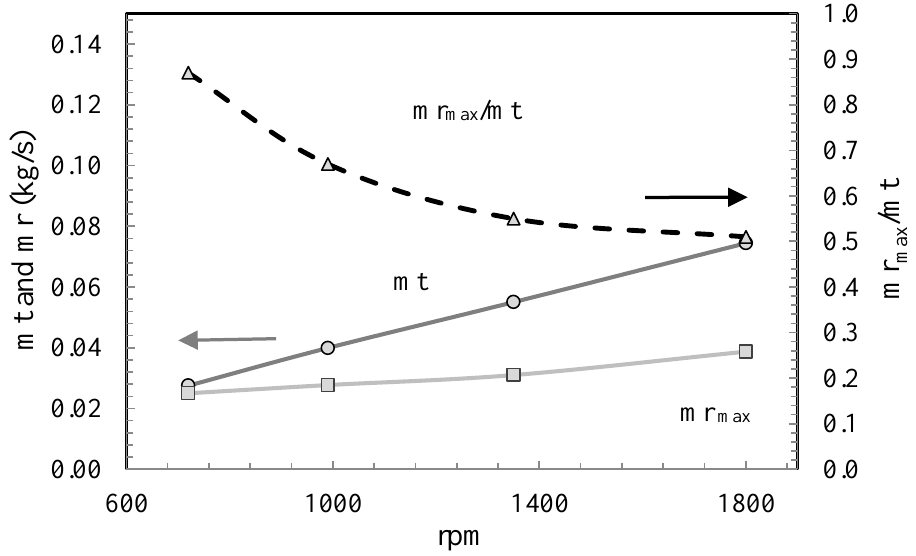
ff erent rotating speed of the